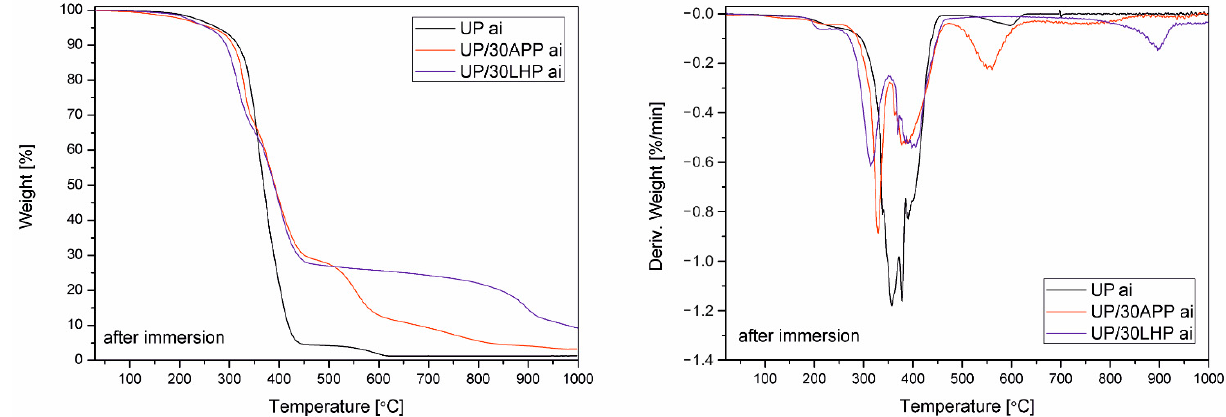
Figure 4. TG and DTG curves of UP and APP and LHP under an inert atmosphere after water soaking.